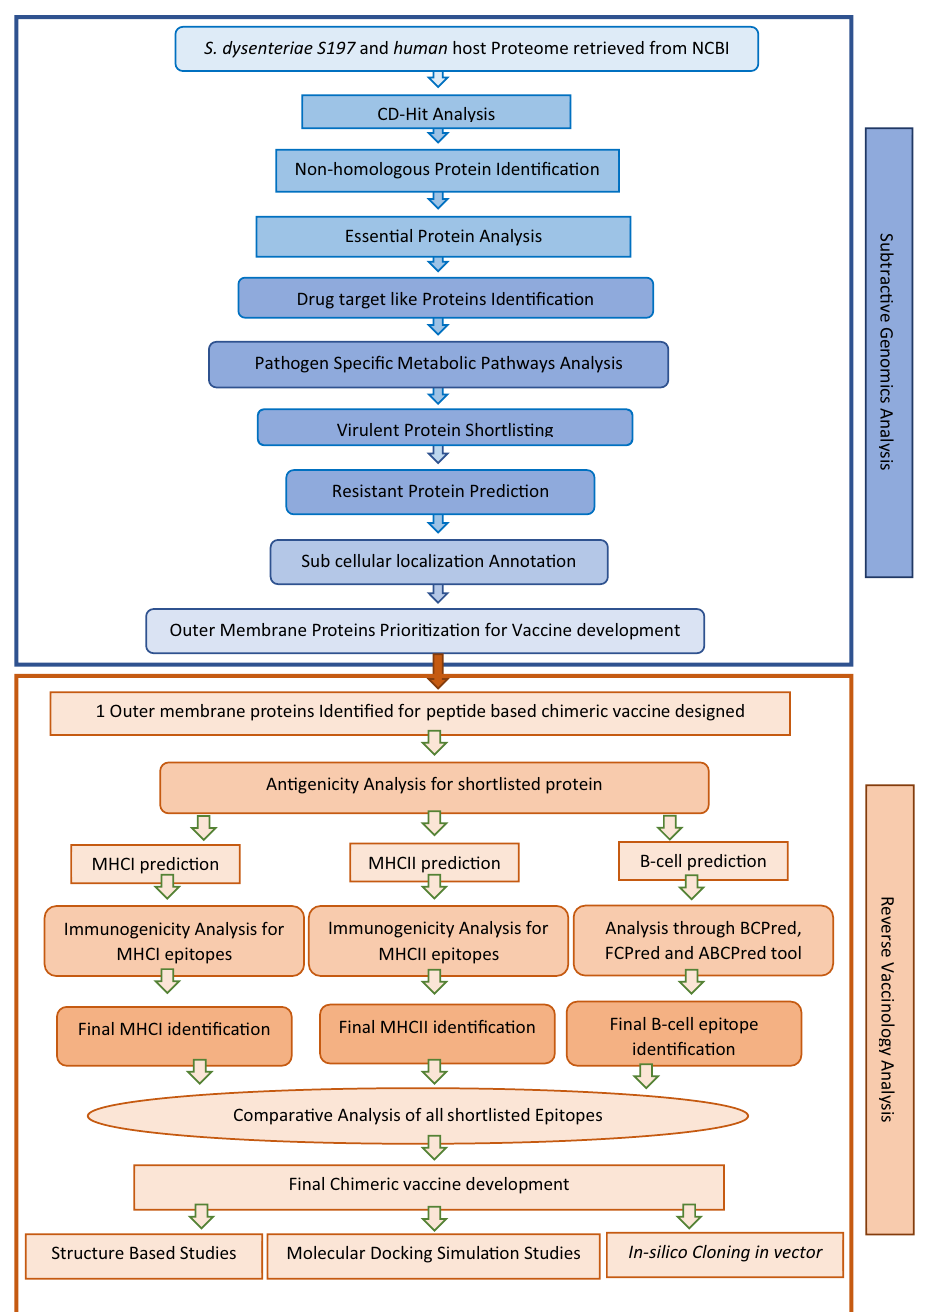
Figure 1. Flow chart for Current study. (A) Subtractive Genomics and Reverse Vaccinology. Flowchart of proposed study for peptide based chimeric vaccine